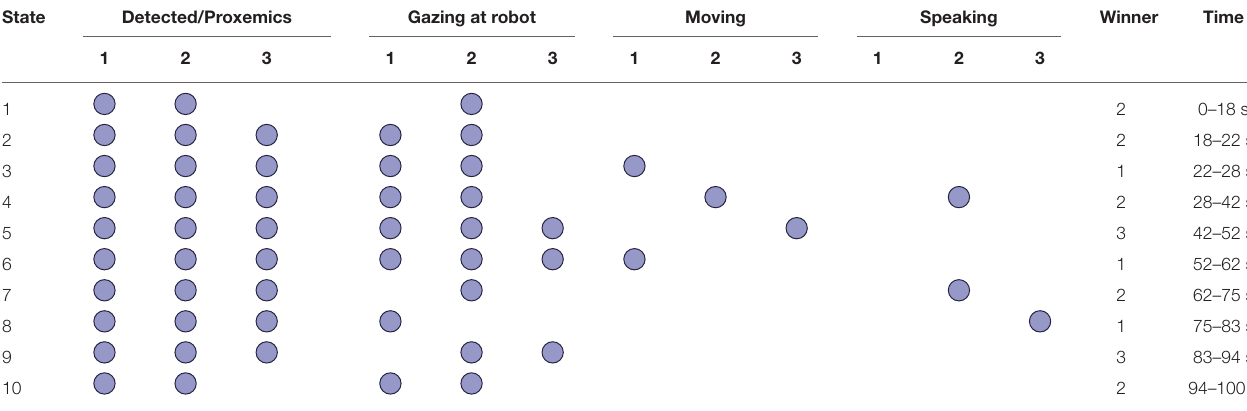
TABLE 3 | Sequence of behavior of three people. State Detected/Proxemics Gazing at robot